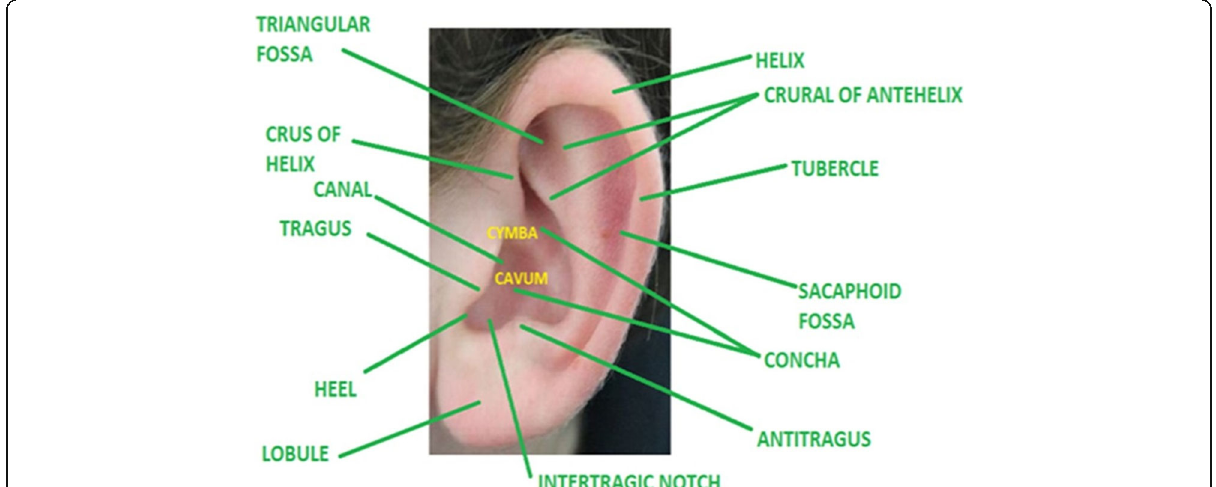
Fig. 1 A photograph showing the morphology and different parts of the